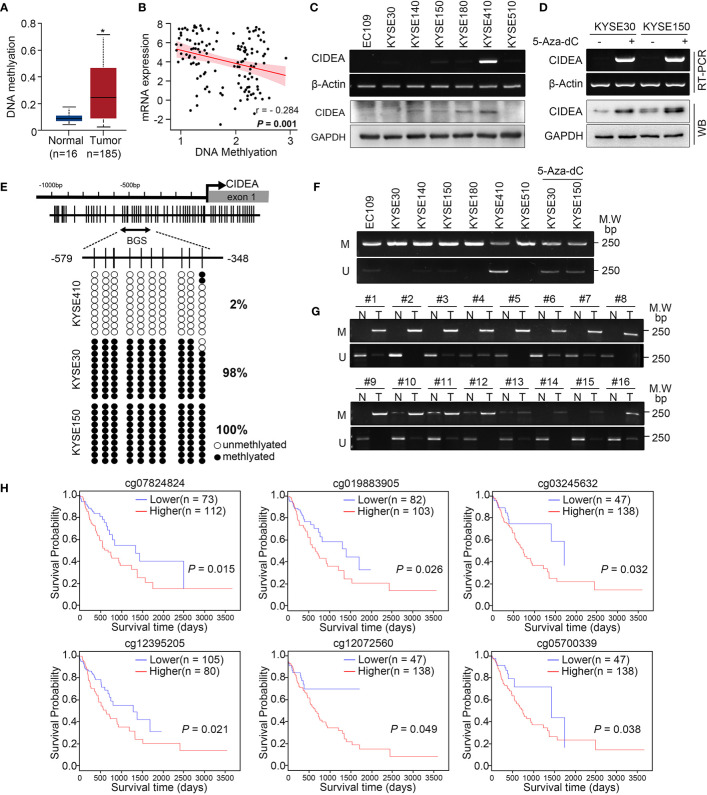
The CIDEA promoter was hyper-methylated and correlated with decreased expression of CIDEA. (A) The methylation level of the CIDEA promoter in TCGA ESCC samples. (B) Pearson’s correlation between DNA methylation and mRNA levels of CIDEA in TCGA ESCC samples. (C) The mRNA and protein level of CIDEA in seven ESCC cell lines were detected by RT-PCR and Western blotting with GAPDH or β-actin as loading controls. (D) RT-PCR and Western blotting analysis showing restored expression of CIDEA in both KYSE30 and KYSE510 cells treated with 5-AZA-DC (10 μM) for 72 h. +, 5-AZA-DC treated; -, 5-AZA-DC untreated. (E) The methylation status of individual CpG sites in the CIDEA promoter (between –579 and –348 bp from the transcription start site) were detected by bisulfite sequencing (BGS) in three ESCC cell lines (KYSE410, KYSE30, and KYSE150). Each row represents an individual cloned allele. The black circles show methylated CpG sites and the white circles show unmethylated CpG sites. (F, G) Representative methylation-specific PCR (MSP) analysis of CIDEA in ESCC cell lines and ESCC tissue samples. M, methylated allele; U, unmethylated allele. N, nontumor tissue; T, tumor tissue. (H) Kaplan-Meier plot showing the impact of CIDEA methylation sites of CIDEA on OS in ESCC patient as analyzed by the MethSurv webtool. Data are presented as the mean ± SD. *P < 0.05; **P < 0.01; ***P < 0.001.